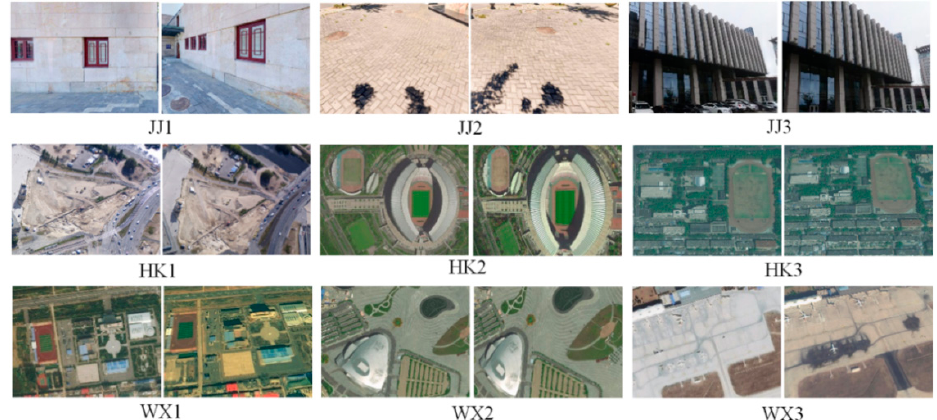
Figure 7. Thumbnails of test data images.